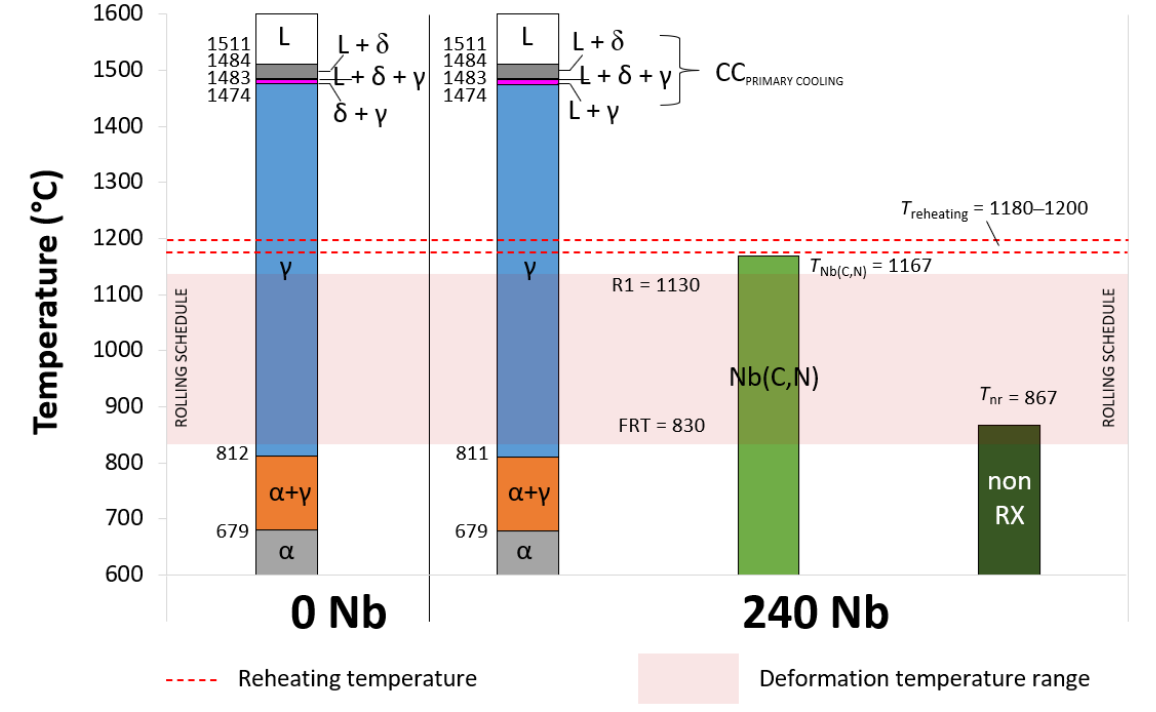
Figure 3. Equilibrium thermodynamic determination of phase stabilities of investigated C-Mn samples, using Thermo-Calc. Both compositions, 0 Nb and 240 Nb, have the same rolling window related to the temperature austenite existence.